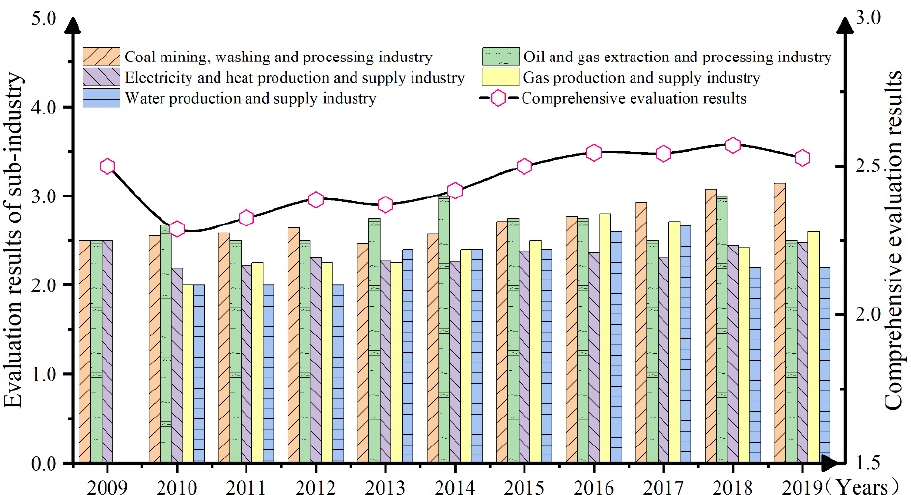
Figure 3. Overall and sub ‐ industry OHSML evaluation results from 2009 to 2019.